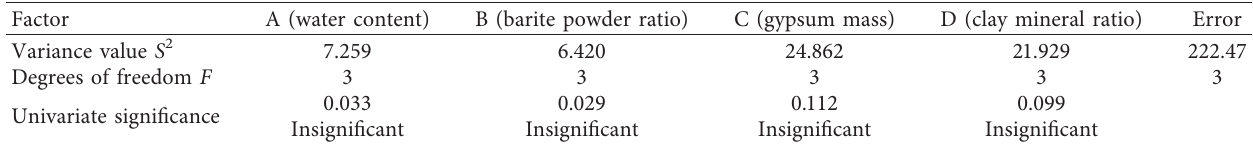
Figure 6: Range analysis of the factors affecting uniaxial compressive strength. Table 11: Variance analysis of uniaxial compressive